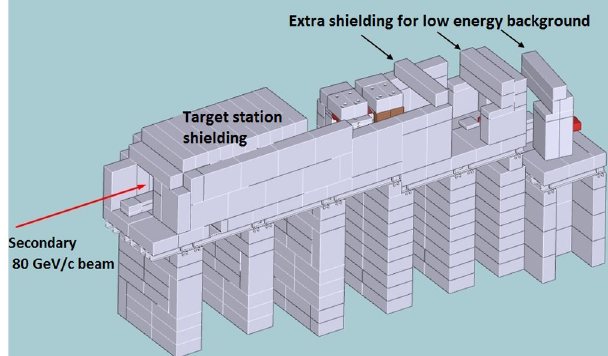
FIG. 8. Final design of the shielding of the H4-VLE beam line, after optimization with FLUKA .